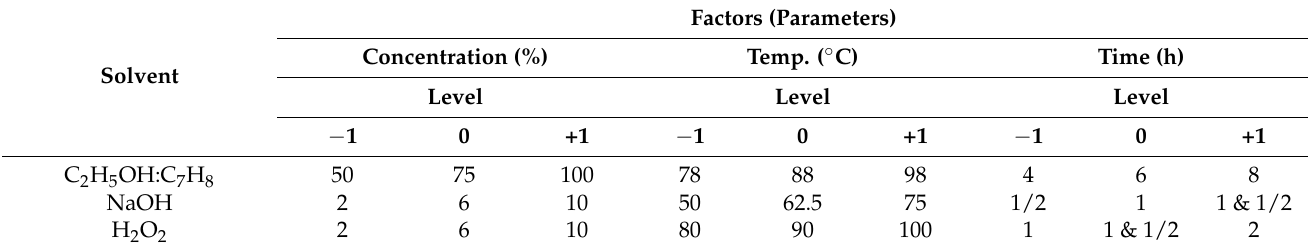
Table 2. Factors and levels of solvents for extraction processes.